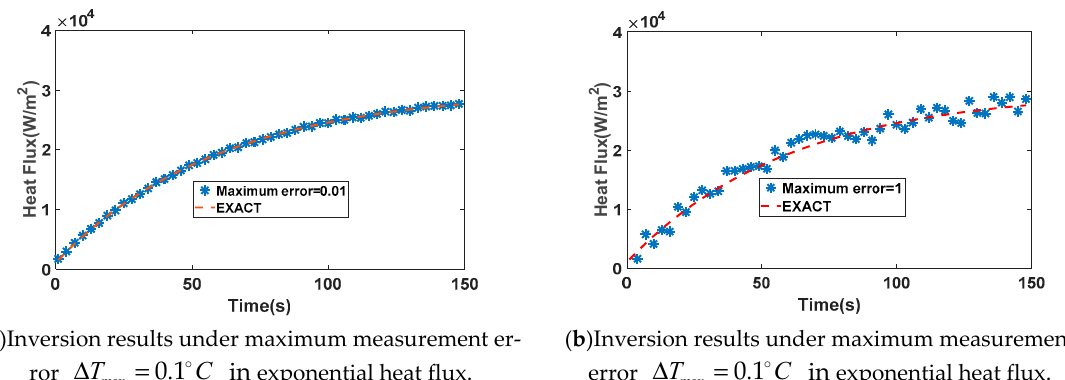
Figure 7. Influence of measurement error on inversion results. ( a ) is inversion result under maximum measurement error ∆ T max = 0.1 ◦ C in exponential heat flux. ( b ) is inversion result under maximum measurement error ∆ T max = 1 ◦ C in exponential heat